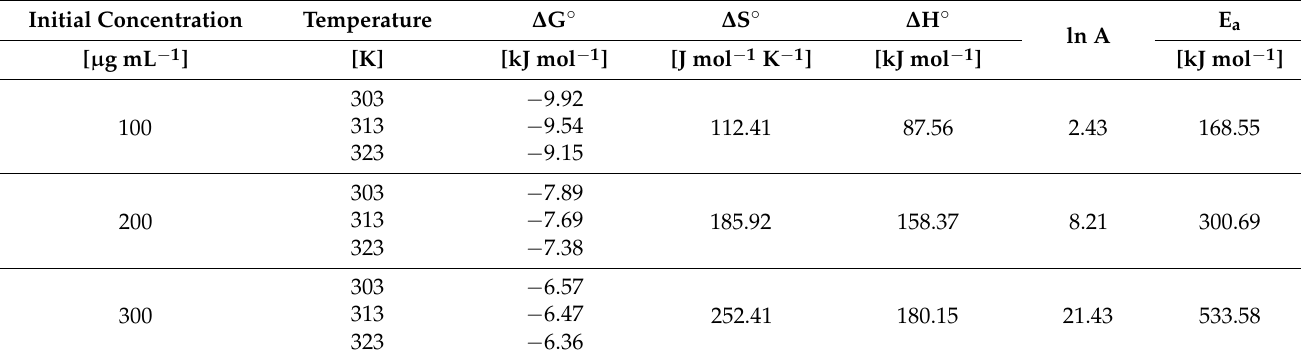
Table 6. Thermodynamic parameters of AR119–NICUS